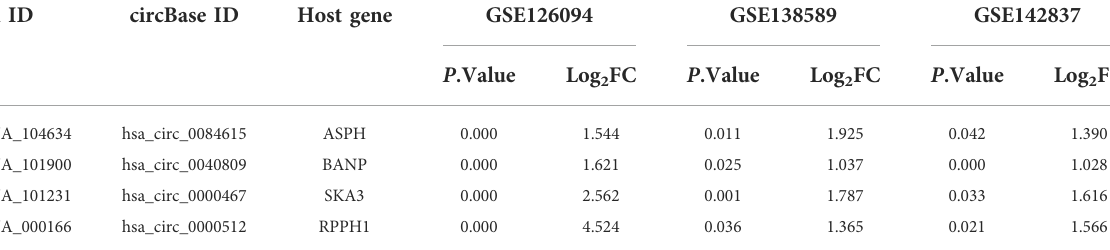
TABLE 2 Overlapped differentially expressed circRNAs from circRNA microarrays in this study. circRNA ID circBase